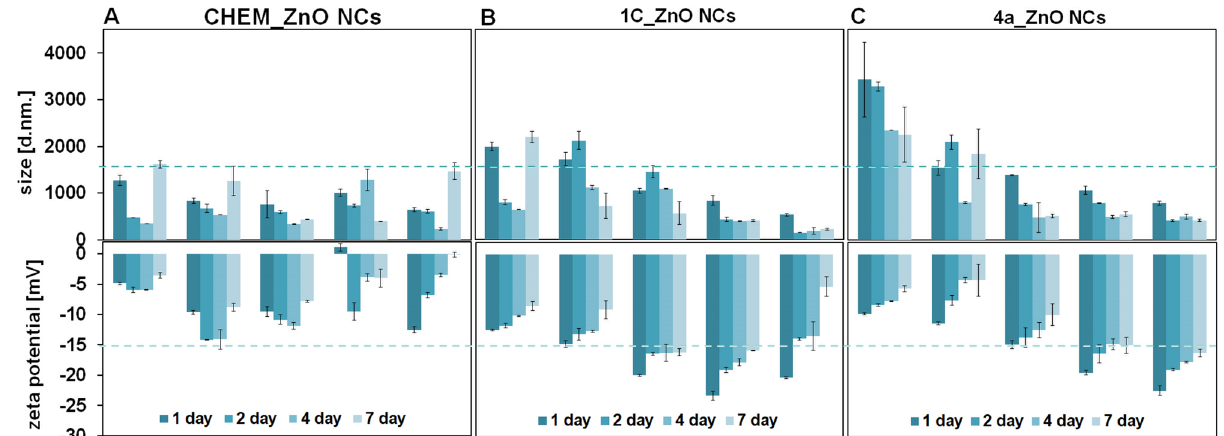
Figure 10. Study of the CHEM_ZnO NCs ( A ), 1C_ZnO NCs ( B ) and 4a_ZnO NCs ( C ) shown for hydrodynamic size (top) and zeta potential (bottom) for 7